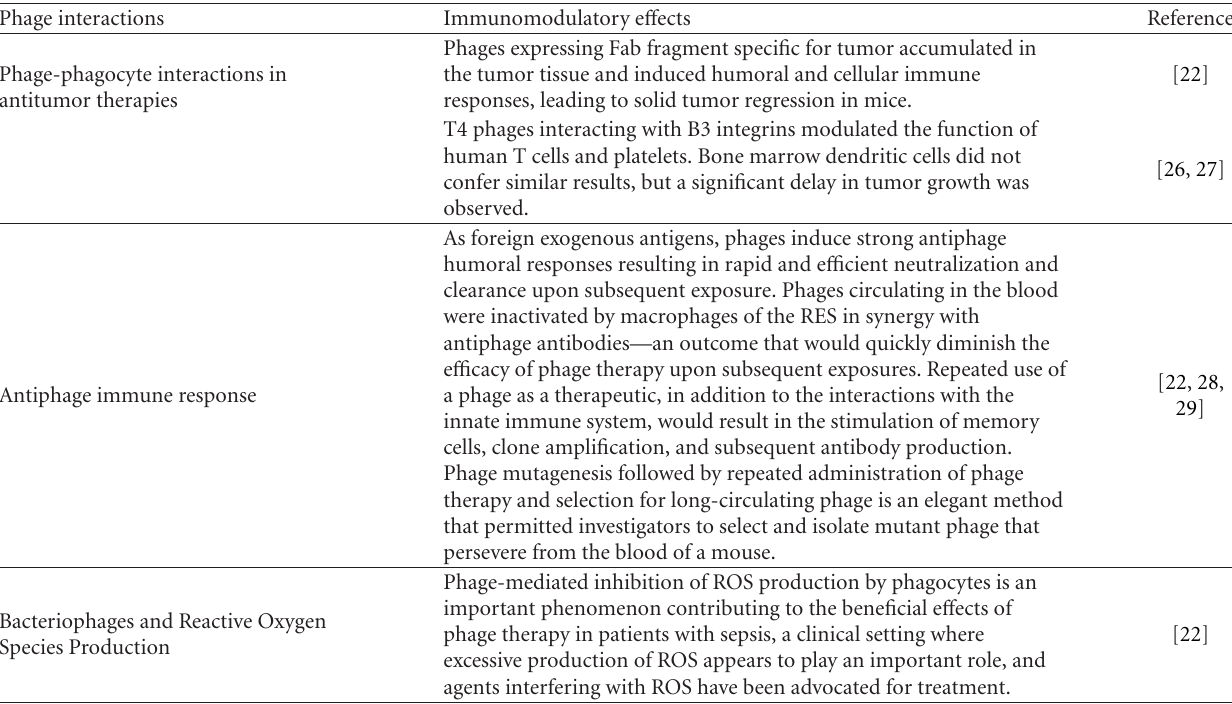
Table 1: Immunomodulatory e ff ects of bacteriophage